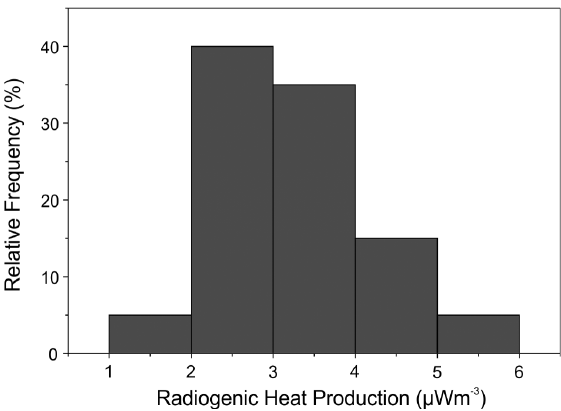
Figure 16 - Histogram showing typical values for the radiogenic heat production ( A ) for selected samples from the Quiriri and Papanduva plutons, Morro Redondo